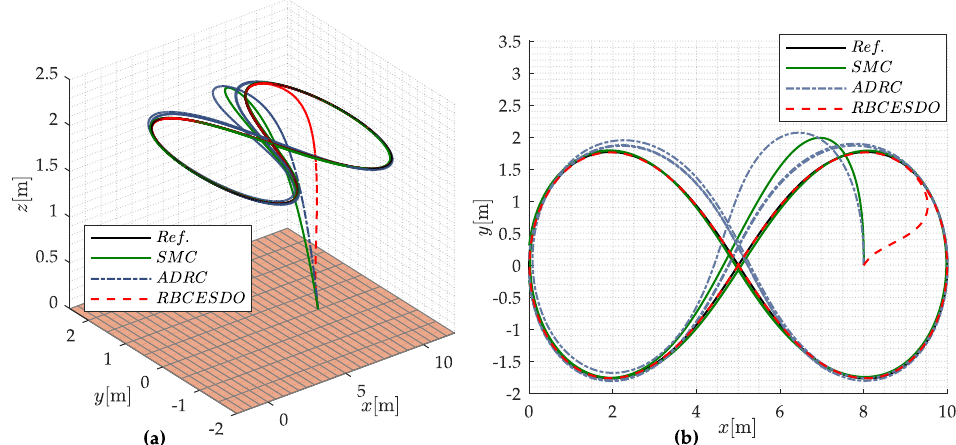
Figure 3. Performance comparison of SMC, ADRC, and RBCESDO in both 3D ( a ) and 2D ( b ) trajectory tracking tests on a quadcopter UAV.